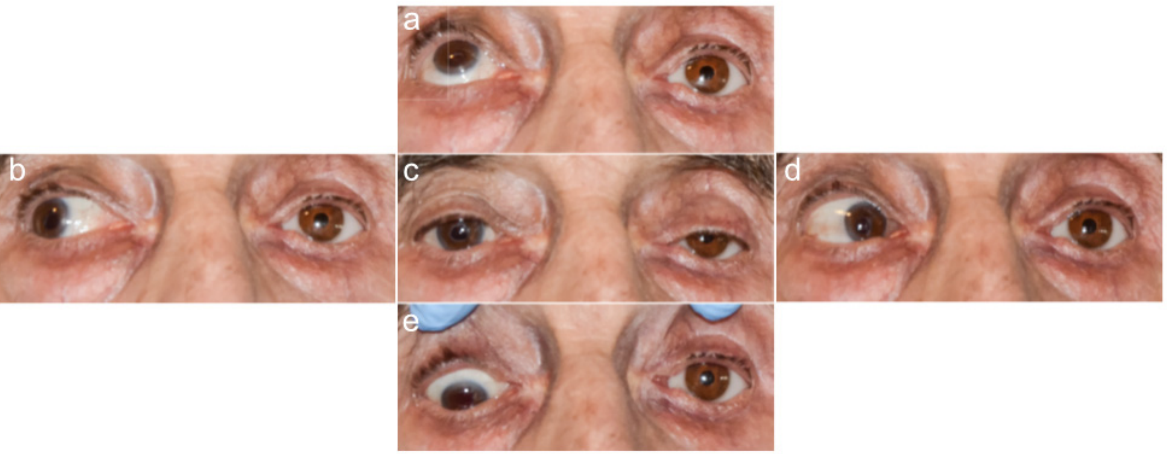
Figure 5. Photographs of a patient without an orbital implant, with an acrylic prosthetic eye on the left; five cardinal directions of gaze: ( a ) up, ( b ) to the right, ( c ) straight ahead, ( d ) to the left, and ( e ) down. Source: Division of Ophthalmology and Ocular Oncology, Jagiellonian University Medical College; own material.